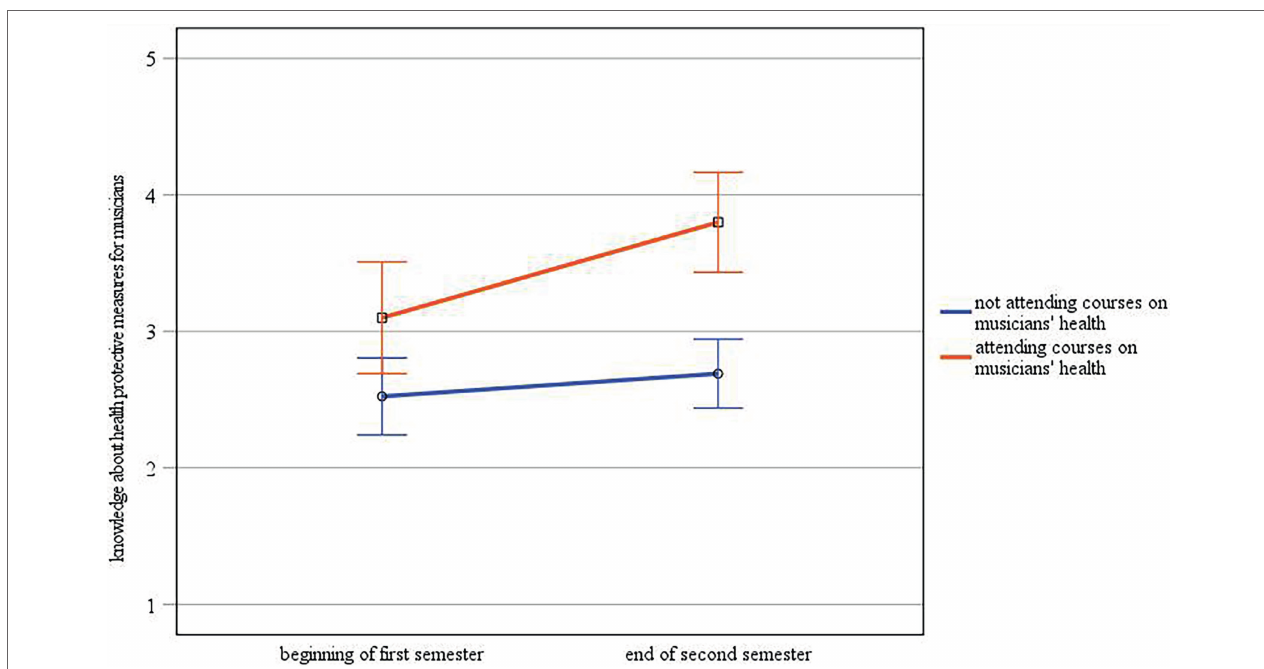
FIGURE 3 | Interaction between time and group regarding self-assessment of knowledge about health protective measures for musicians (error bars represent 95% CI).